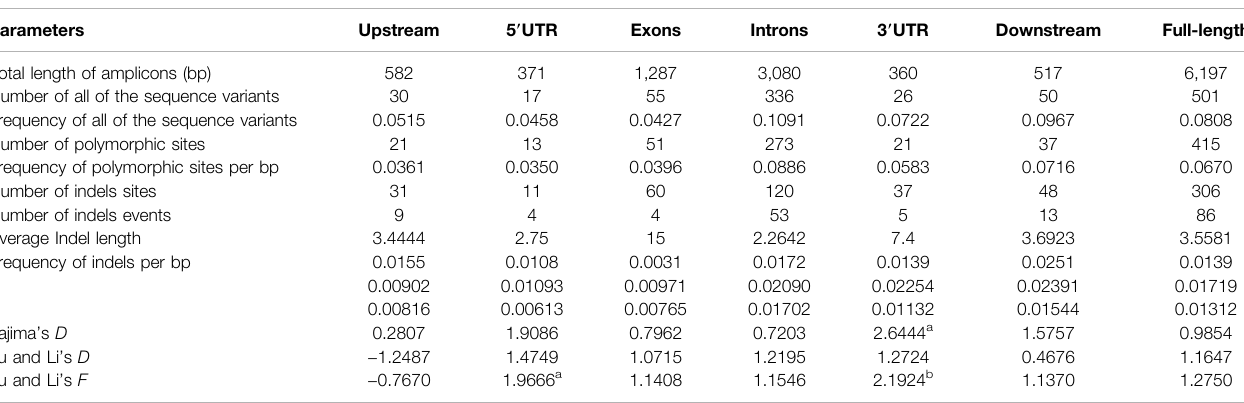
TABLE 2 | Summary of parameters for the analysis of nucleotide polymorphisms. Parameters Upstream 5 9 UTR Exons Introns 3 9 UTR Downstream Full-length Total length of amplicons